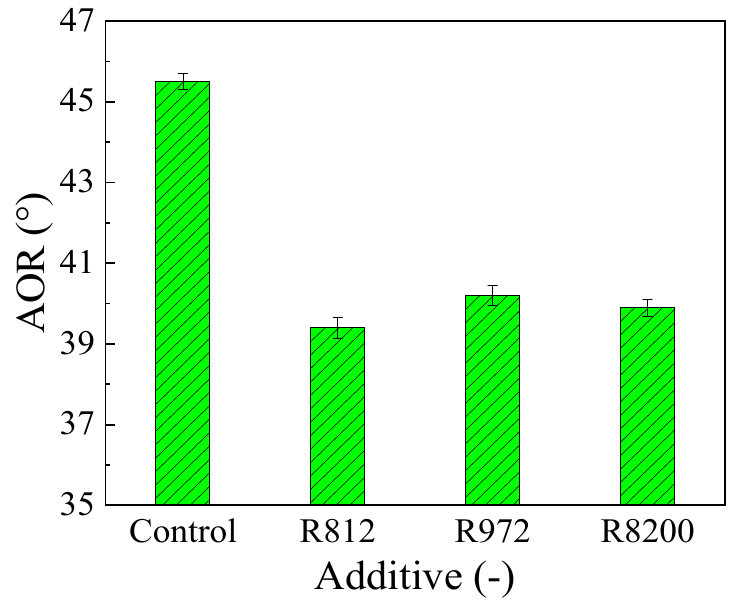
Figure 5. AOR of the powders with different additives.